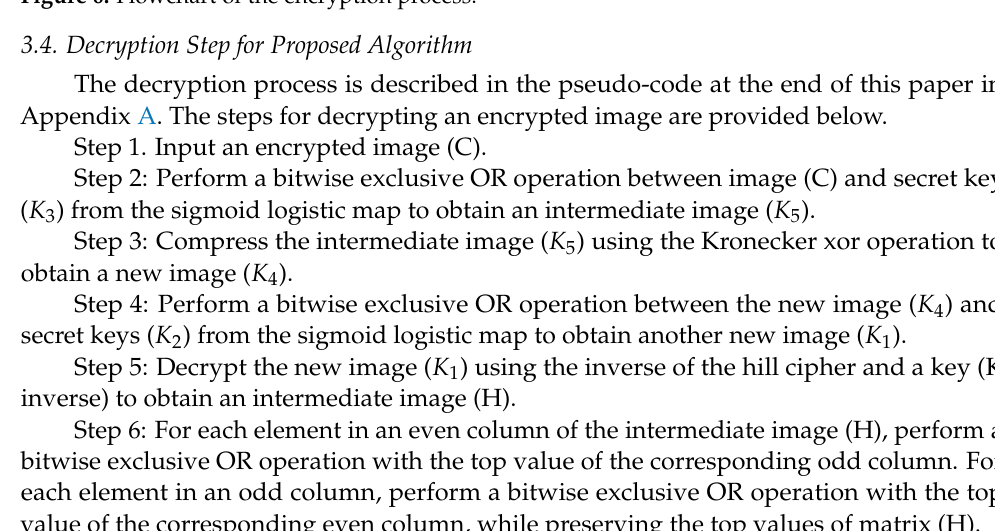
Figure 6. Flowchart of the encryption process.